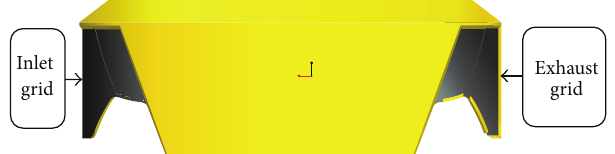
Figure 1: Distributions of the inlet grid and exhaust grid in an engine compartment.